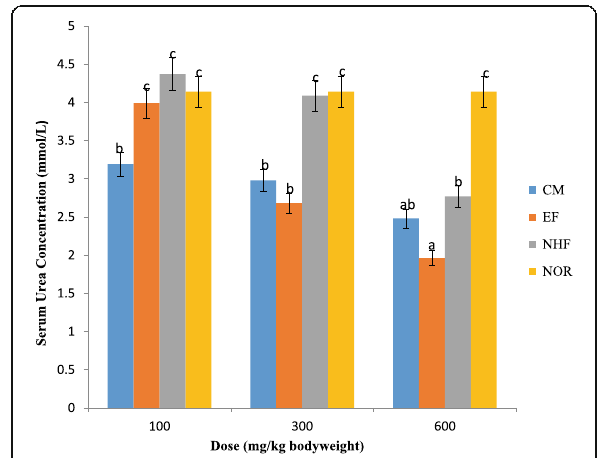
Fig. 7 Effect of crude extract and fractions of Gymnema sylvestre on serum urea concentrations of rats. Mean with different superscripts differ significantly (p < 0.05). Key: NOR: normal control, CM: crude